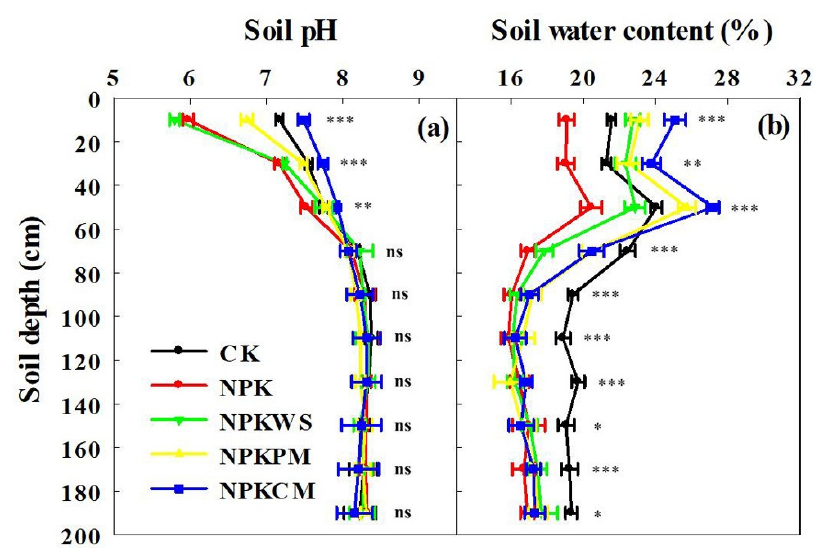
Figure 1. Soil pH and soil water content in the 0–200 cm depth after 32 years of fertilization in Ver- tisols. ( a ) Soil pH and ( b ) soil water content. CK: no fertilization; NPK: chemical fertilizers; NPKWS: NPK plus wheat straw; NPKPM: NPK plus pig manure; NPKCM: NPK plus cattle manure. The asterisks indicate significant differences among planting systems within the same soil layer, * p < 0.05, ** p < 0.01, *** p < 0.001; ns: not significant.